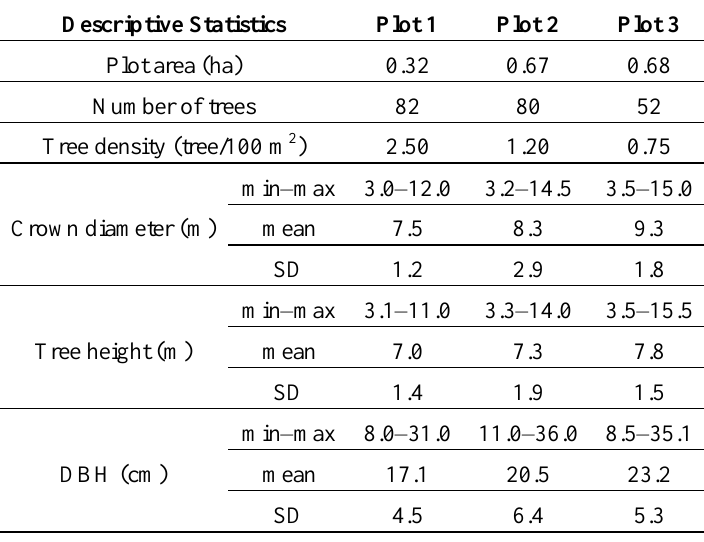
Table 2. Descriptive statistics for the collected mangrove data.